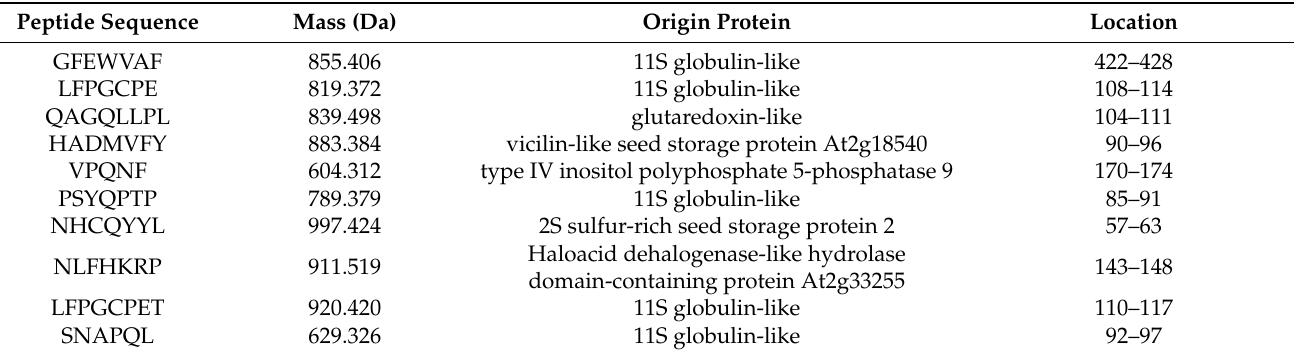
Table 5. LC-MS/MS identification of the antioxidant peptides.